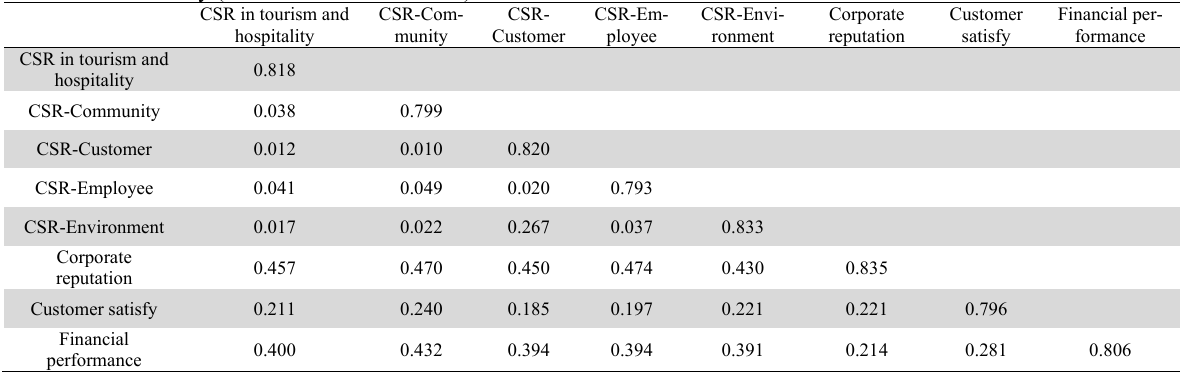
Discriminant Validity (Fornell-Larcker Criterion)